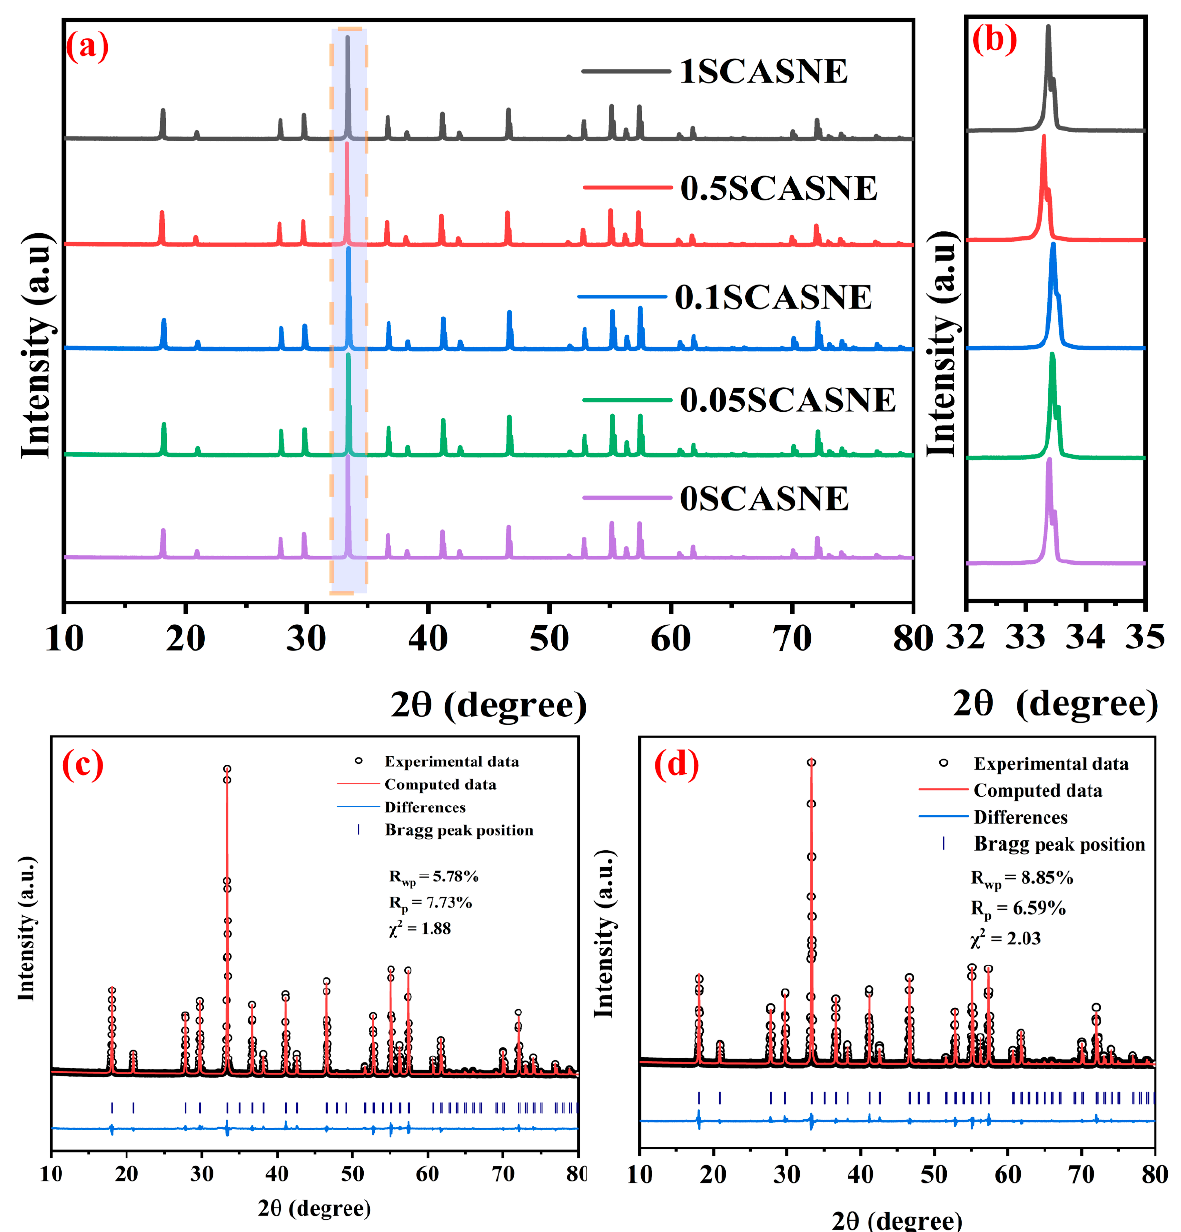
Figure 2. XRD patterns of ( a ) serial SCASNE ceramics with different phosphor-doping concentra- tions; ( b ) magnified XRD patterns around 33.5°; Rietveld-refinement patterns of ( c ) 0SCASNE and ( d ) 1SCASNE.